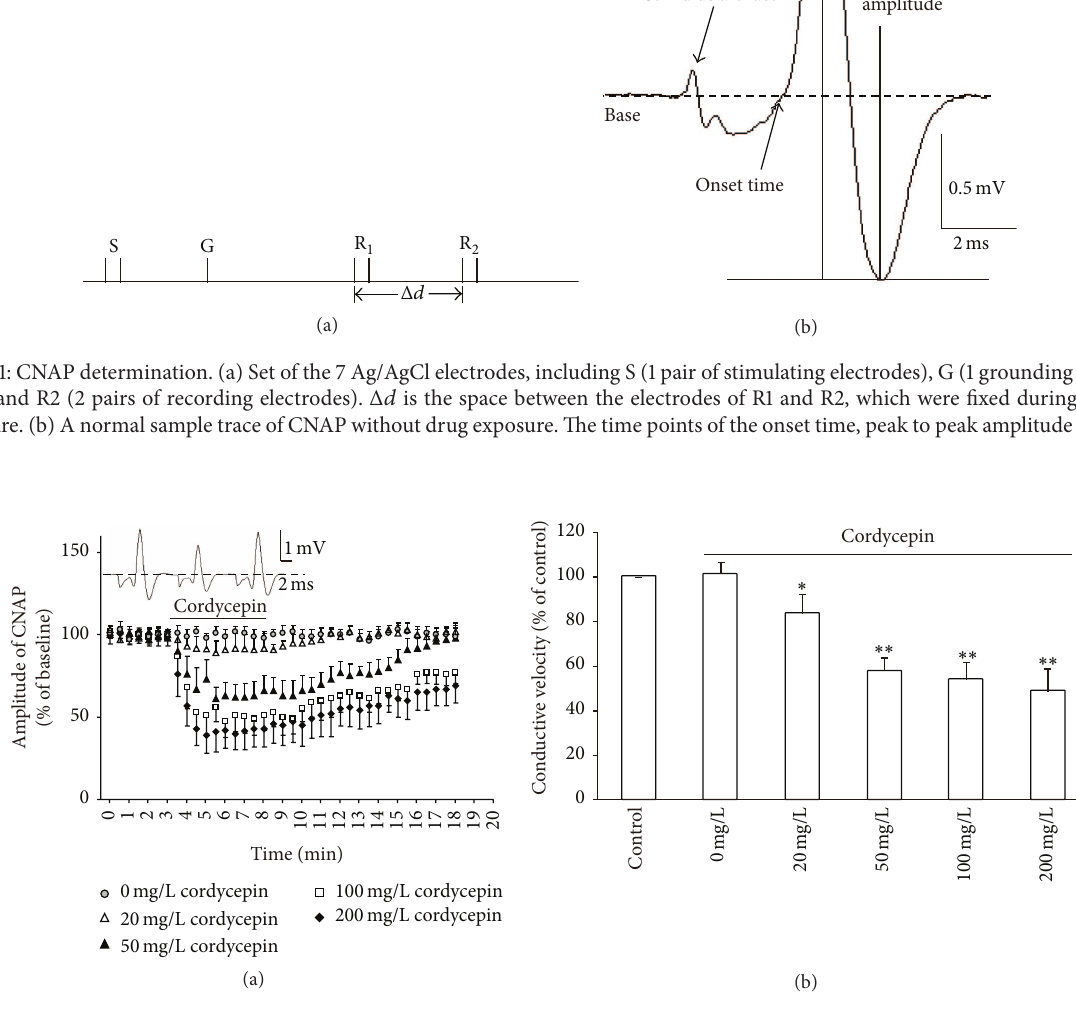
Figure 2: Effects of cordycepin on amplitude and conductive velocity of compound nerve action potential (CNAP) in isolated frog sciatic nerve. (a) Sample traces (top) show the CNAP recorded before, during, and after 50mg/L cordycepin was applied. Below are the time courses of the effects of different concentrations of cordycepin (0, 20, 50, 100, and 200 mg/L) on the amplitude of CNAP conduction. Horizontal bar indicates the bath application of cordycepin. (b) Summary of changes in conductive velocity of CNAP induced by different concentrations of cordycepin. The velocity of the stable state before exposure to cordycepin is defined as the control value and scaled to 100%. ∗ 𝑃 < 0.05 , ∗∗ 𝑃 < 0.01 compared with the control